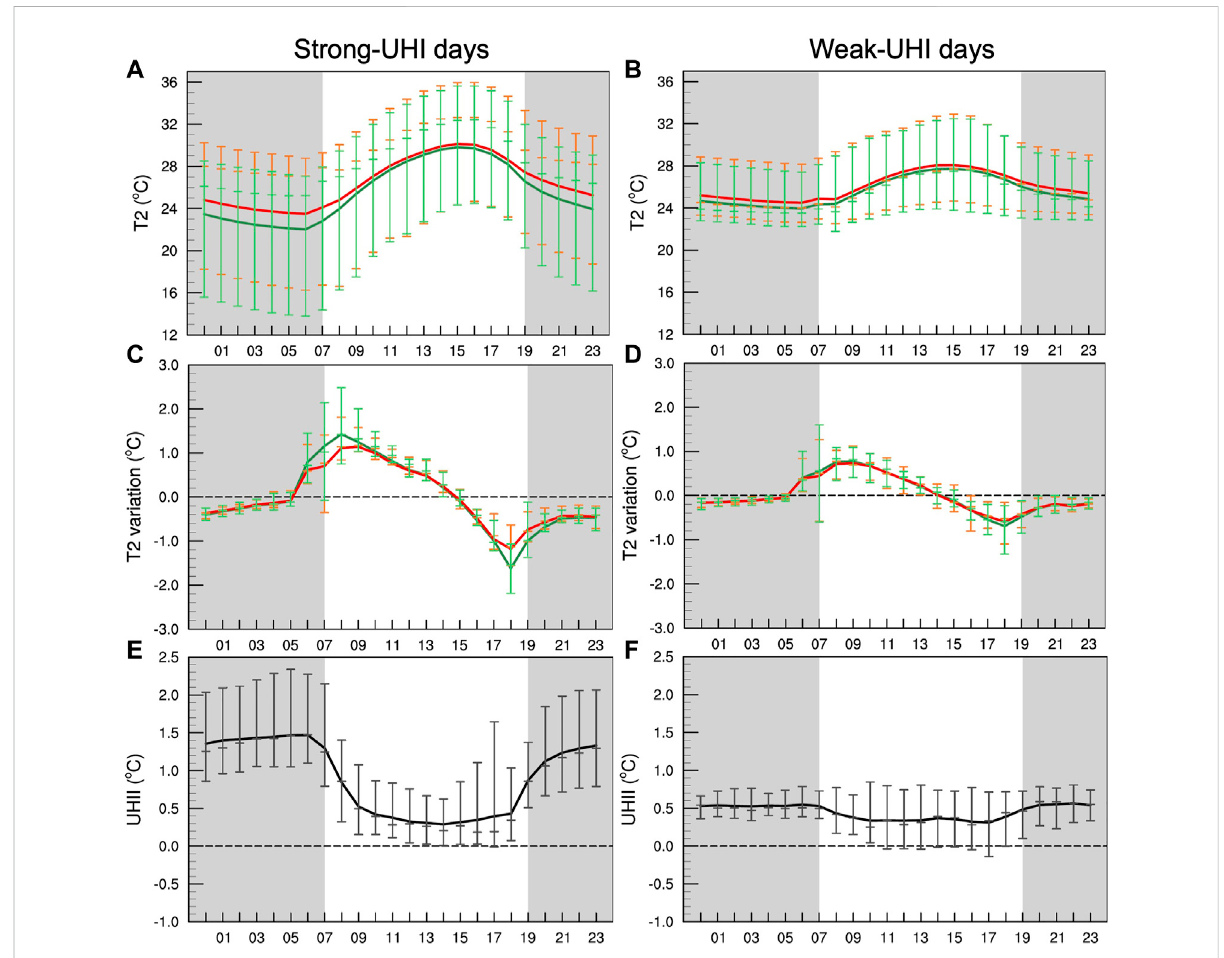
FIGURE 4 (A) The diurnal variations in the observed domain-averaged surface air temperature over the urban (red) and rural (green) regions averaged on the strong-UHI days. The error bars show the outliers (i.e., 10th and 90th percentiles are whiskers). (C) is similar to (A) but for the warming/cooling rates. (E) The diurnal variations in UHI intensity, with error bars representing the outliers (i.e., 10th and 90th percentiles are whiskers). (B) , (D) , and (F) are similar to (A) , (C) , and (E) but on the weak-UHI days. The gray zones denote the nocturnal time window from 1900 LST to 0700